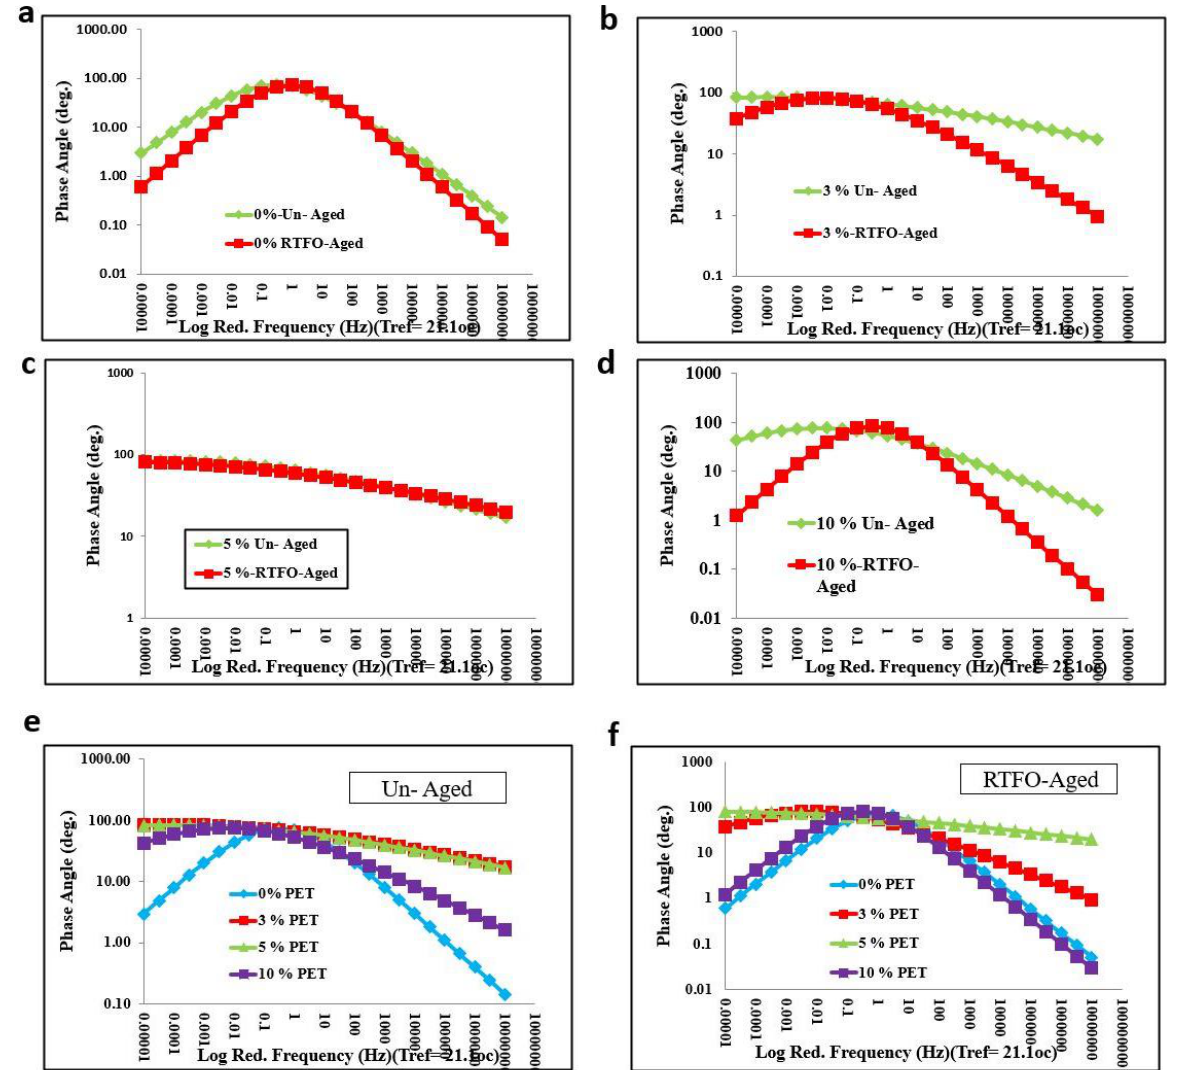
Figure 10. Master curve of phase angle of unaged and RTFO-aged binder with PET content of ( a ) 0%, ( b ) 3%, ( c ) 5%, ( d ) 10%, ( e ) PET on unaged binder, and ( f ) PET on aged binder.